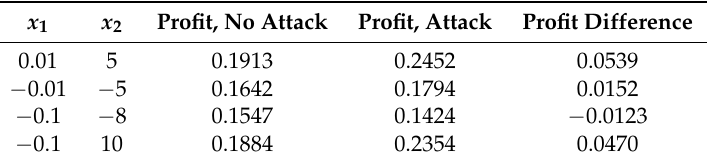
Table 5. Profit results for four different initial conditions with and without cyberattacks over a sampling period, with ρ (cid:48) = 30.